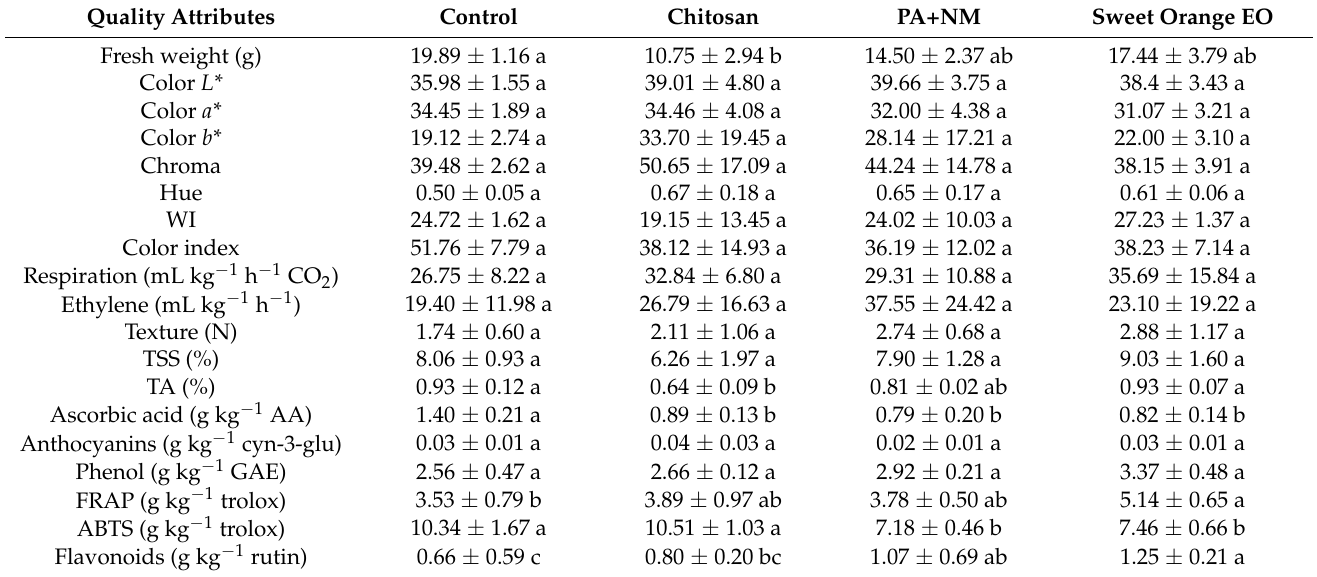
Table 2. Effect of foliar spray of chitosan, phosphoric acid plus micronutrients (PA+MN), and sweet orange EO on strawberry fruit quality after harvest. Values ( n = 6 for color measurements; n = 3 for others quality attributes) in rows followed by the same letter are not significantly different; p ≤